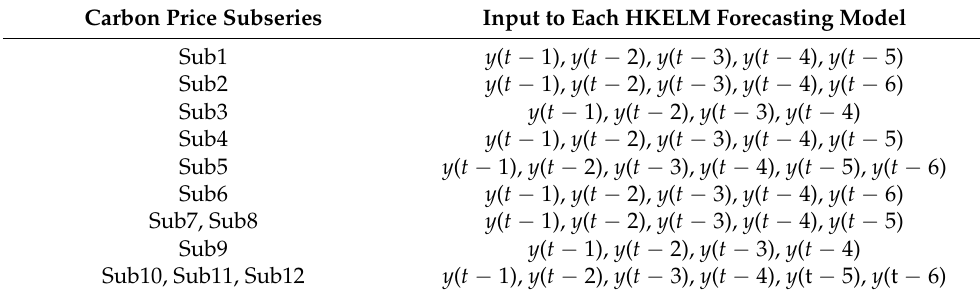
Table 4. Input variables of each forecasting model of the subseries of carbon prices. Carbon Price Subseries